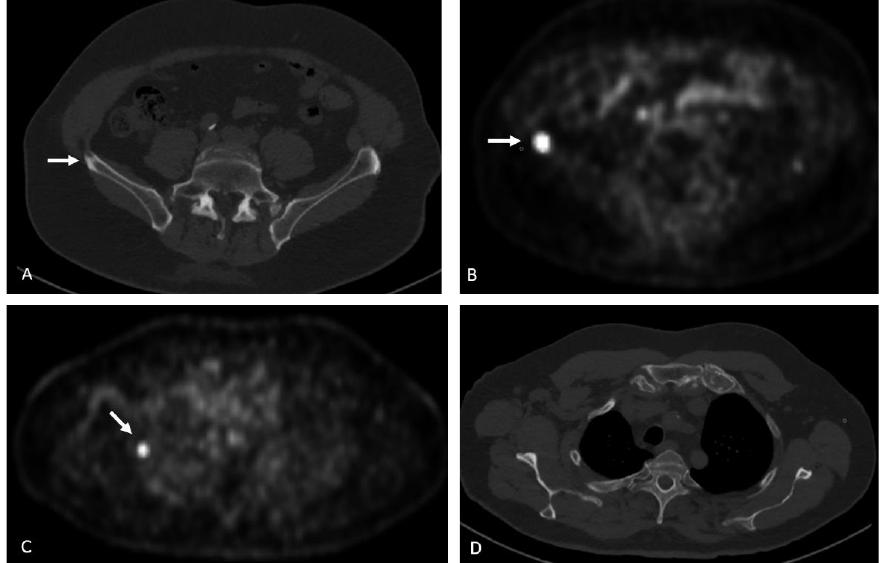
Figure 16. Seventy-four-year-old male with history of prostate cancer, status post-prostatectomy, now with rising PSA levels. NECT at the level of the sacrum ( A ) shows subtle sclerosis of the right iliac crest (arrow). 18F DCFPyL PET image ( B ) shows intense radiotracer uptake in the lesion (arrow). 18F DCFPyL PET image at the level of the scapula ( C ) shows radiotracer uptake within the right lateral 2nd rib (arrow) without a discernable abnormality on CT ( D ).